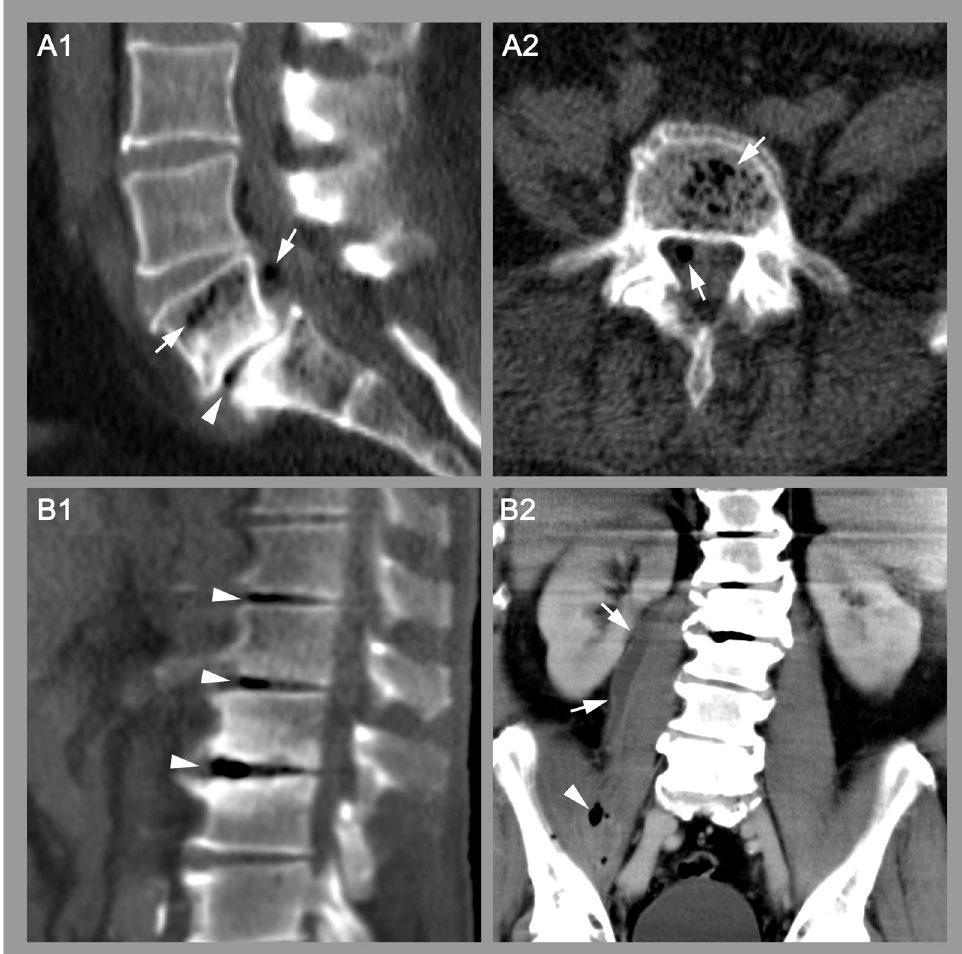
Figure 2. Imaging examples of two patients with confirmed spondylodiscitis. A . Sagittal ( A1 ) and transverse ( A2 ) CT images showing gas within the disc (arrowhead), within the vertebra and within an epidural abscess (arrows) of a 50-year-old patient with urosepsis and spondylodiscitis L5/S1. Blood cultures and intraoperative tissue samples revealed Escherichia coli as the causative pathogen. B . Sagittal ( B1 ) and coronal ( B2 ) CT images of intervertebral gas ( B1 , arrowheads) within three discs and gas ( B2 , arrowheads) within a psoas abscess ( B2 , arrows) of a 75-year-old patient with spondy- lodiscitis L1-3. Blood cultures and biopsy samples revealed Streptococcus pyogenes as the causative pathogen.